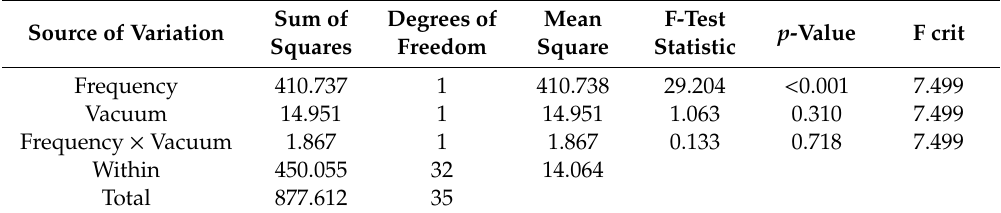
Table 4. Statistical Analysis of Variance results for phase “a” (%).